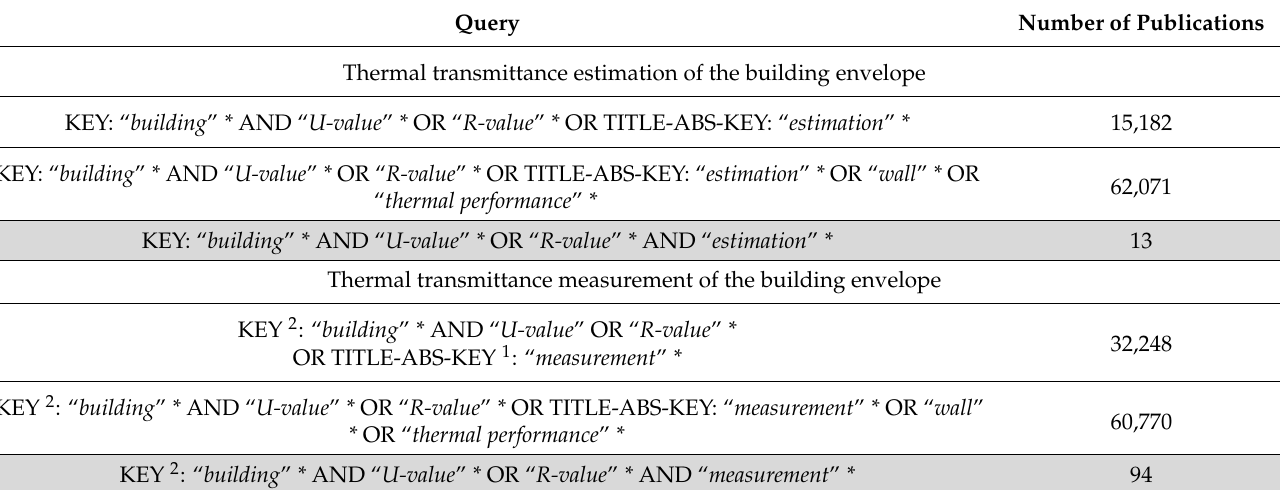
Table 2. Queries used and number of publications obtained for topics “ estimation ” and “ measurement ” (source: authors’ elaboration, 16 March 2023).